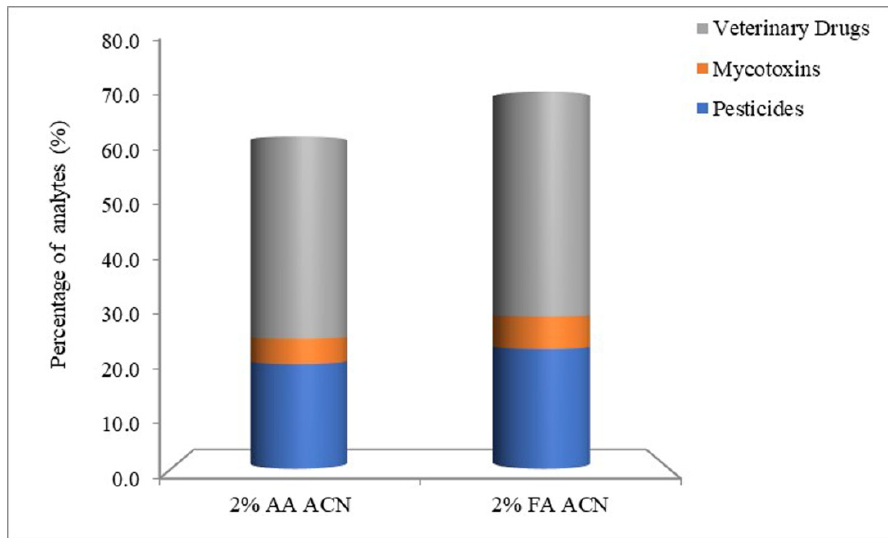
Figure 1. Comparison of ME values between 0.8 and 1.2 from the series of AA in ACN extraction solutions.